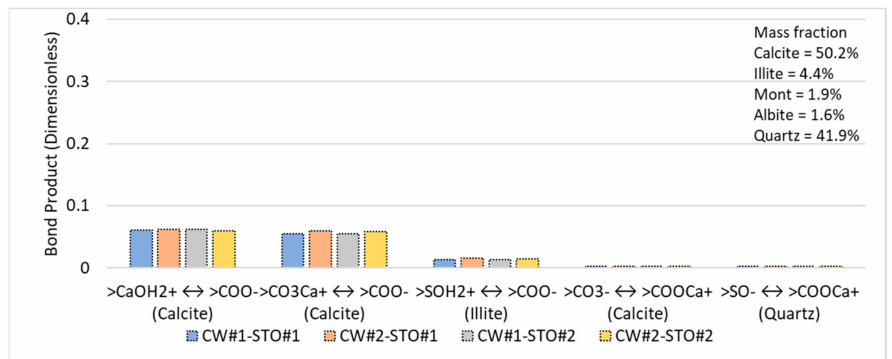
Figure 9. Bond product (oil adhesion mechanism) of PSR#4 using